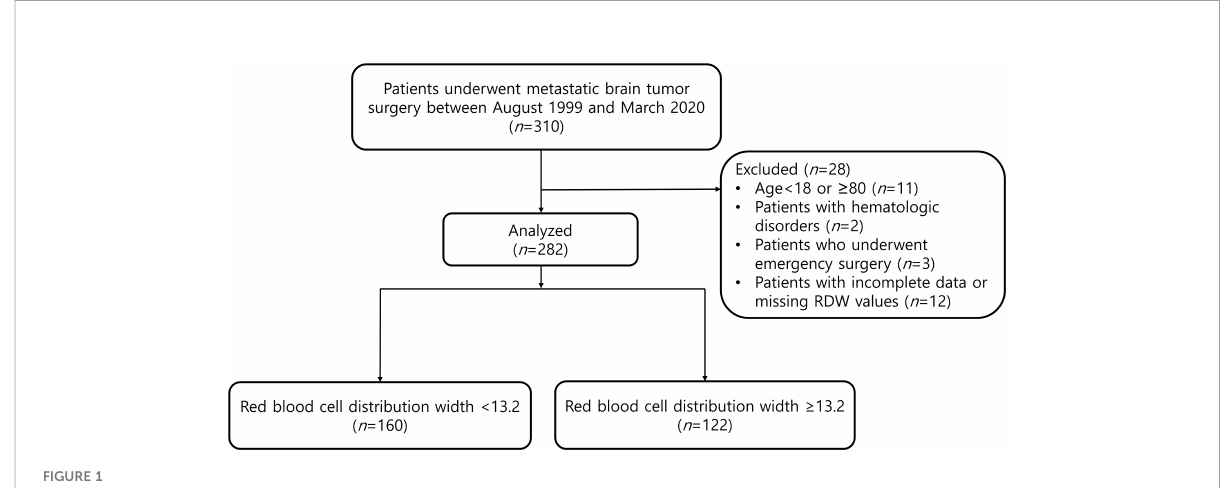
FIGURE 1 Study fl